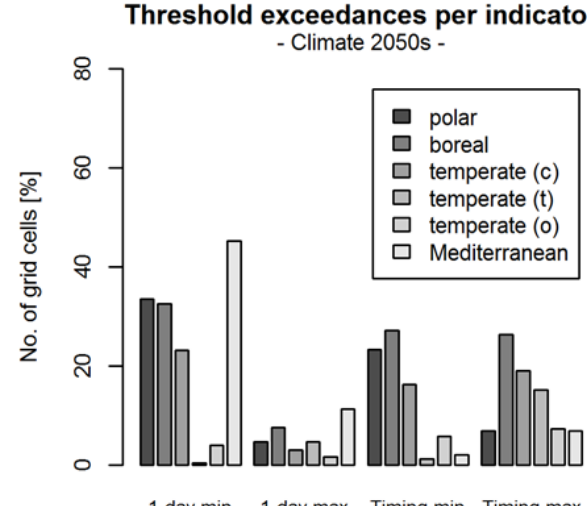
Fig. 7. Percentage of grid cells which are relevantly affected by cli- mate change according to climate zones in Europe. Magnitude and timing of low and high flows are